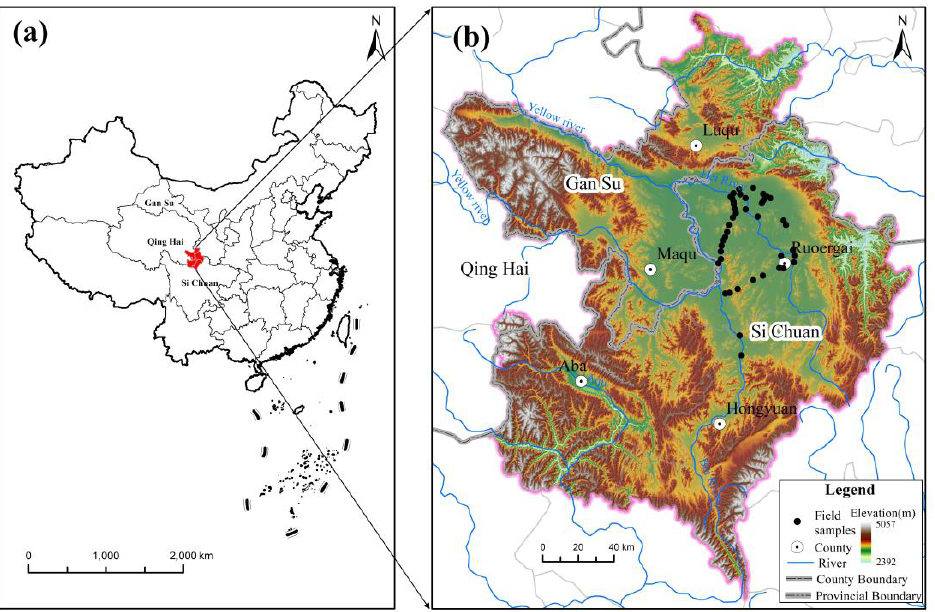
Figure 1. ( a ) The geographical location of the Zoigê alpine grassland in China. ( b ) Overview map of Zoigê alpine grassland study